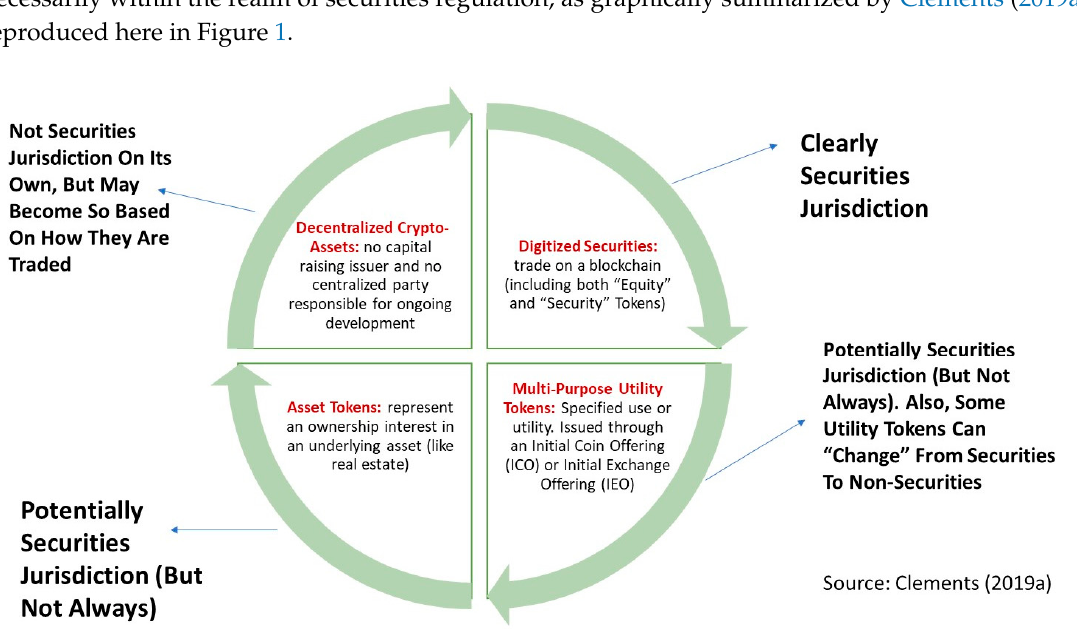
Figure 1. Crypto-Assets: Evolution of Form and Jurisdictional Uncertainty.